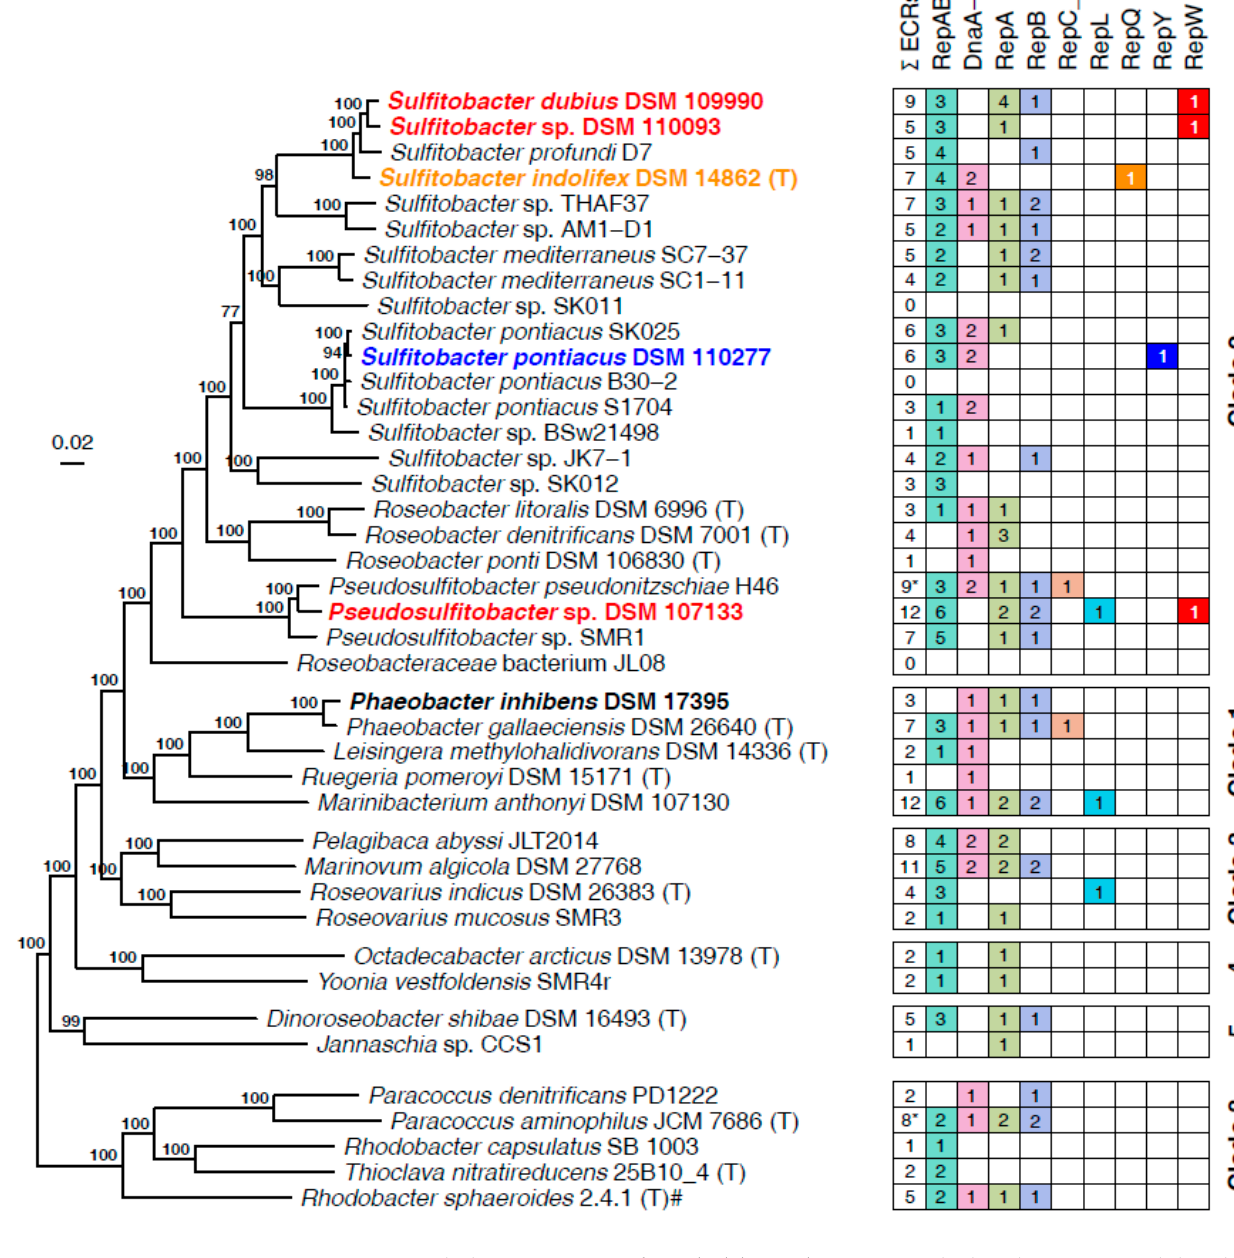
Figure 1. Phylogenomic tree of 41 Rhodobacterales strains with closed genomes and distribution of their extrachromosomal replicons (ECRs). The phylogenetic tree was constructed from 30,310 amino acid positions of 92 housekeeping genes. The monophyly of the family Roseobacteraceae and a sister group position of the Rhodobacteraceae (Clade 8) was confirmed by a phylogenomic analysis with the draft genome of the deep branching taxon Neomegalonema perideroedes DSM 15528. The matrix on the right side depicts the number of ECRs classified by their replication system. An asterisk (*) indicates that one of the ECRs contained only a putative replicase, which function has not been tested in Rhodobacterales . Strains sequenced and investigated within this study are colored in accordance with their novel plasmid systems and shown in bold. # The correct taxonomic name is Cereibacter sphaeroides 2.4.1. Genome accession numbers are listed in Table S1.